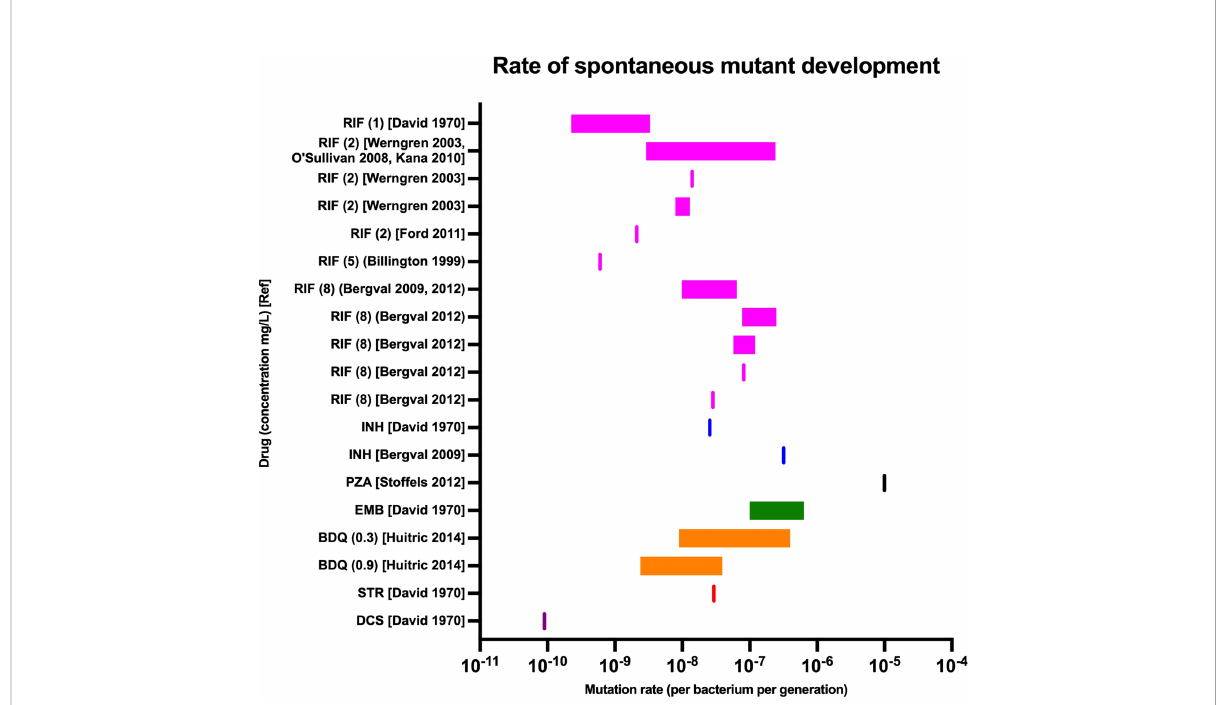
FIGURE 1 Spontaneous in vitro mutation rates for key antituberculous drugs (McGrath et al., 2014). Rates were measured in a variety of laboratory and clinical strains from varying bacterial lineages. Drug names abbreviated: RIF, rifampicin; INH, isoniazid; PZA, pyrazinamide; EMB, ethambutol; BDQ, bedaquiline; STR, streptomycin; DCS, D-cycloserine. Concentrations in mg/L shown in brackets followed by original reference (David, 1970; Billington et al., 1999; Werngren and Hoffner, 2003; O ’ Sullivan et al., 2008; Bergval et al., 2009, 2012; Huitric et al., 2010; Kana et al., 2010; Ford et al., 2011; Stoffels et al.,